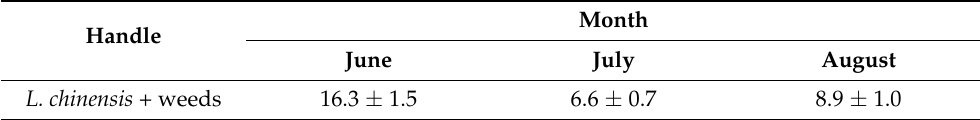
Table 2. Total soil mercury concentrations (ng · g − 1 ). Handle